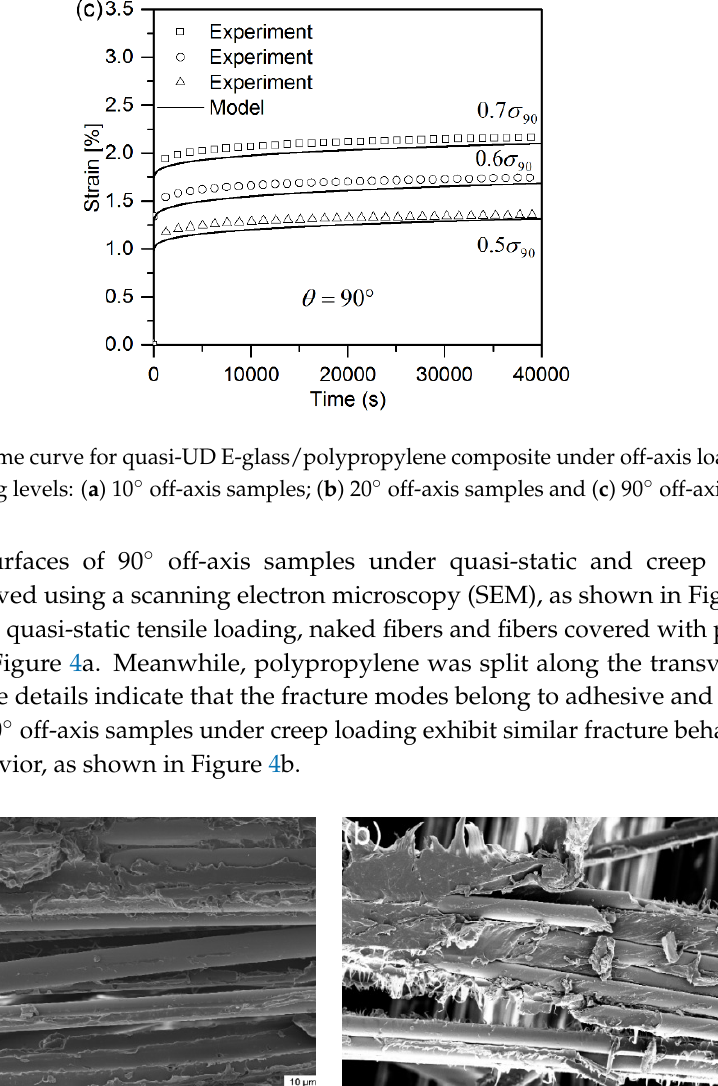
5 gives representative cyclic loading ‐ unloading curves of quasi ‐ UD E ‐